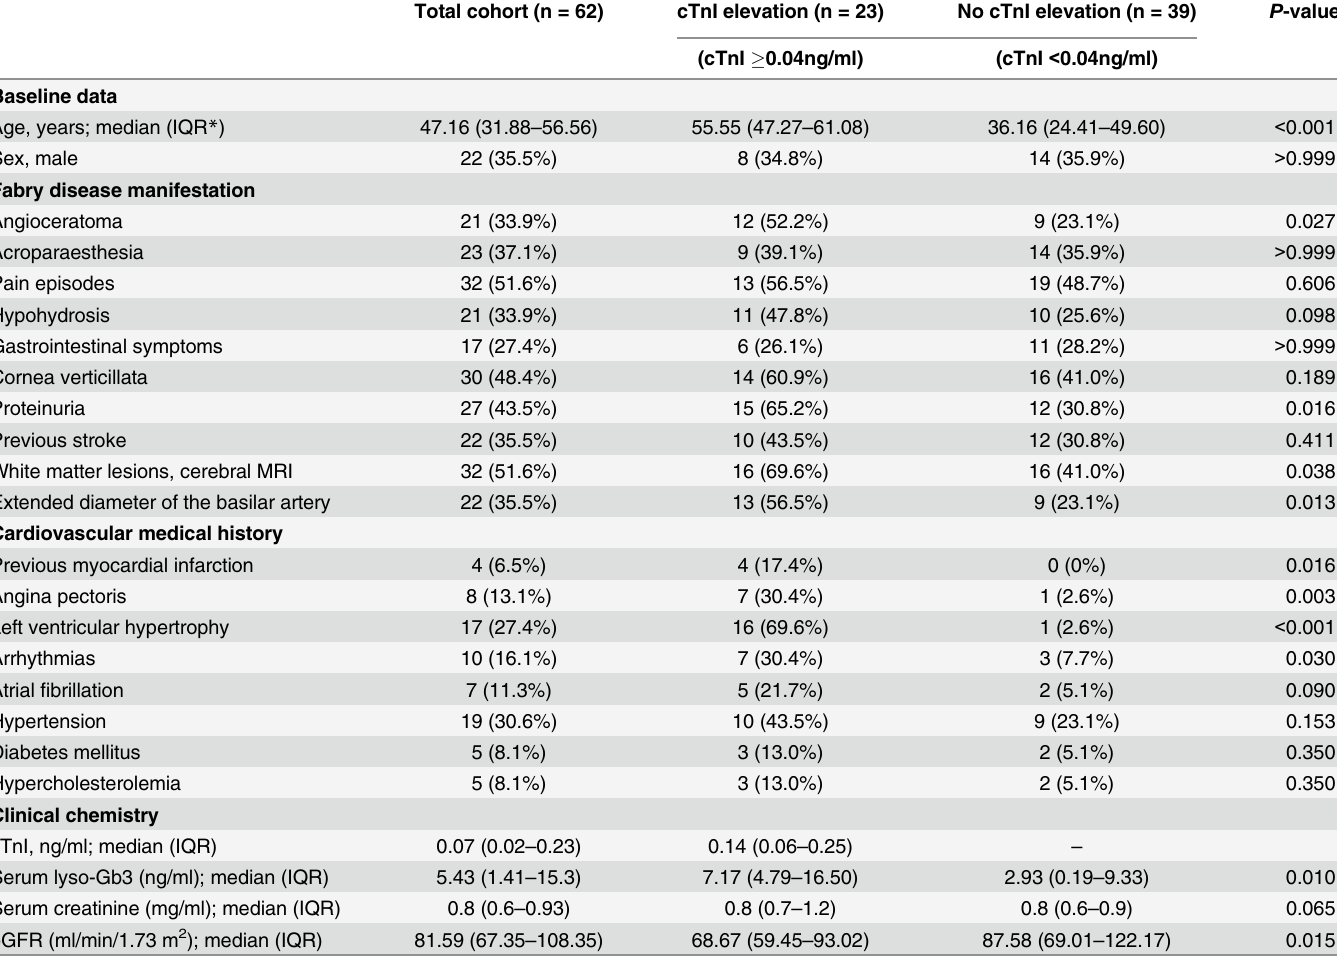
Table 1. Patients with Fabry disease: comparison of patients with cTnI elevation (cid:1) 0.04 ng/ml versus without. Total cohort (n = 62) cTnI elevation (n = 23) No cTnI elevation (n = 39) P